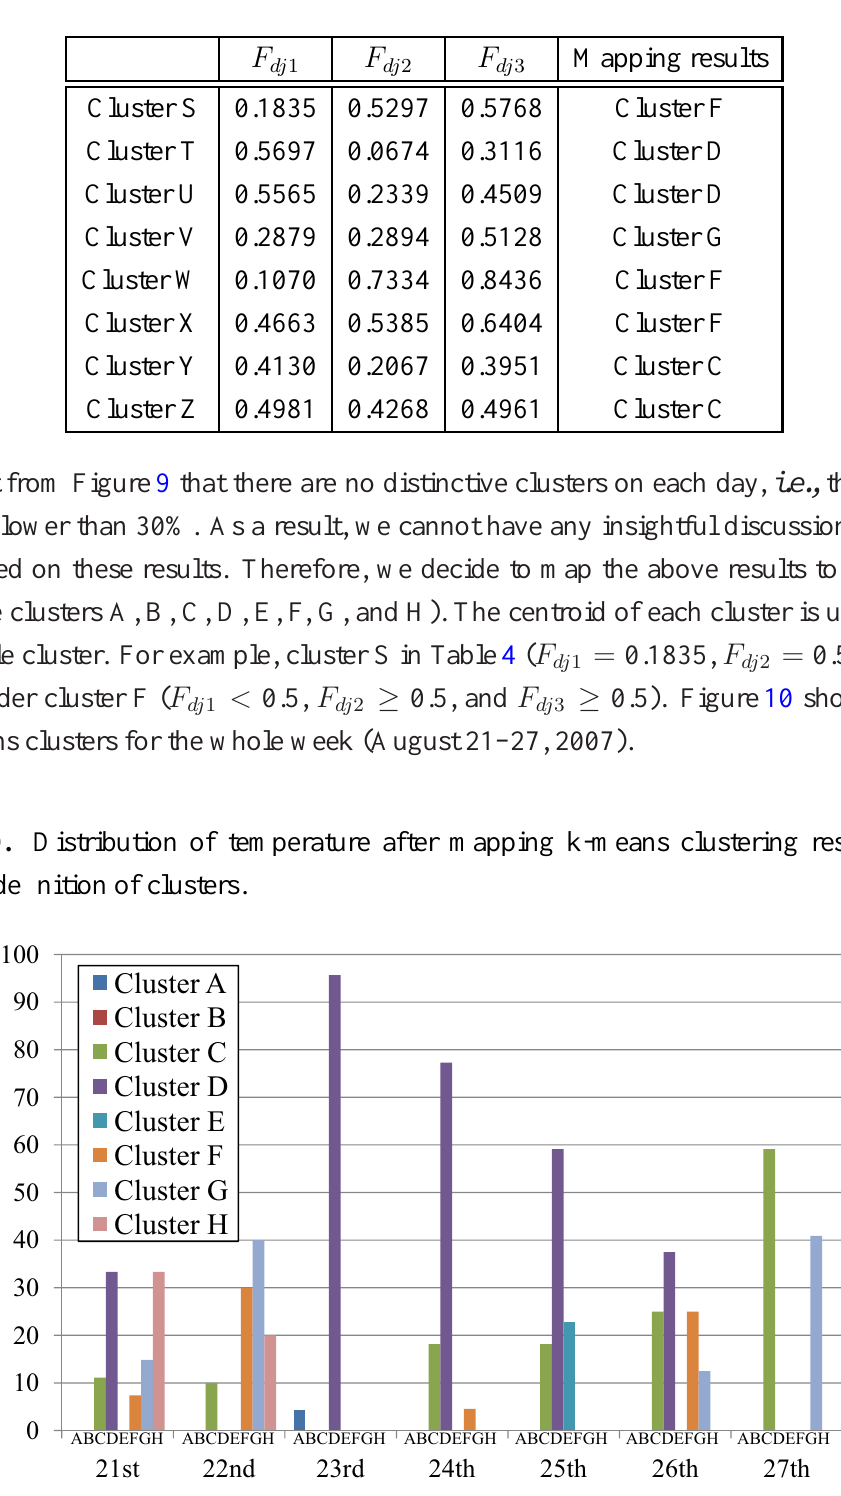
Table 4. Centroids of each cluster on August 26, 2007.